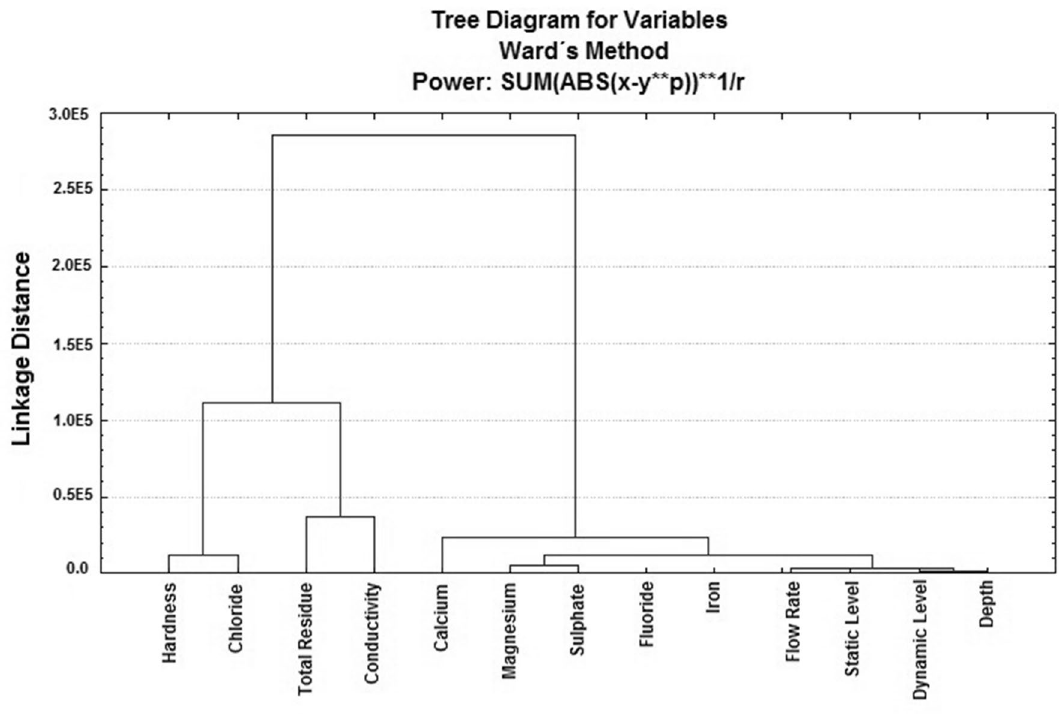
Figure 6. “R” mode dendrogram from the hierarchical cluster analysis, using Statistica, version 7.0 115 .